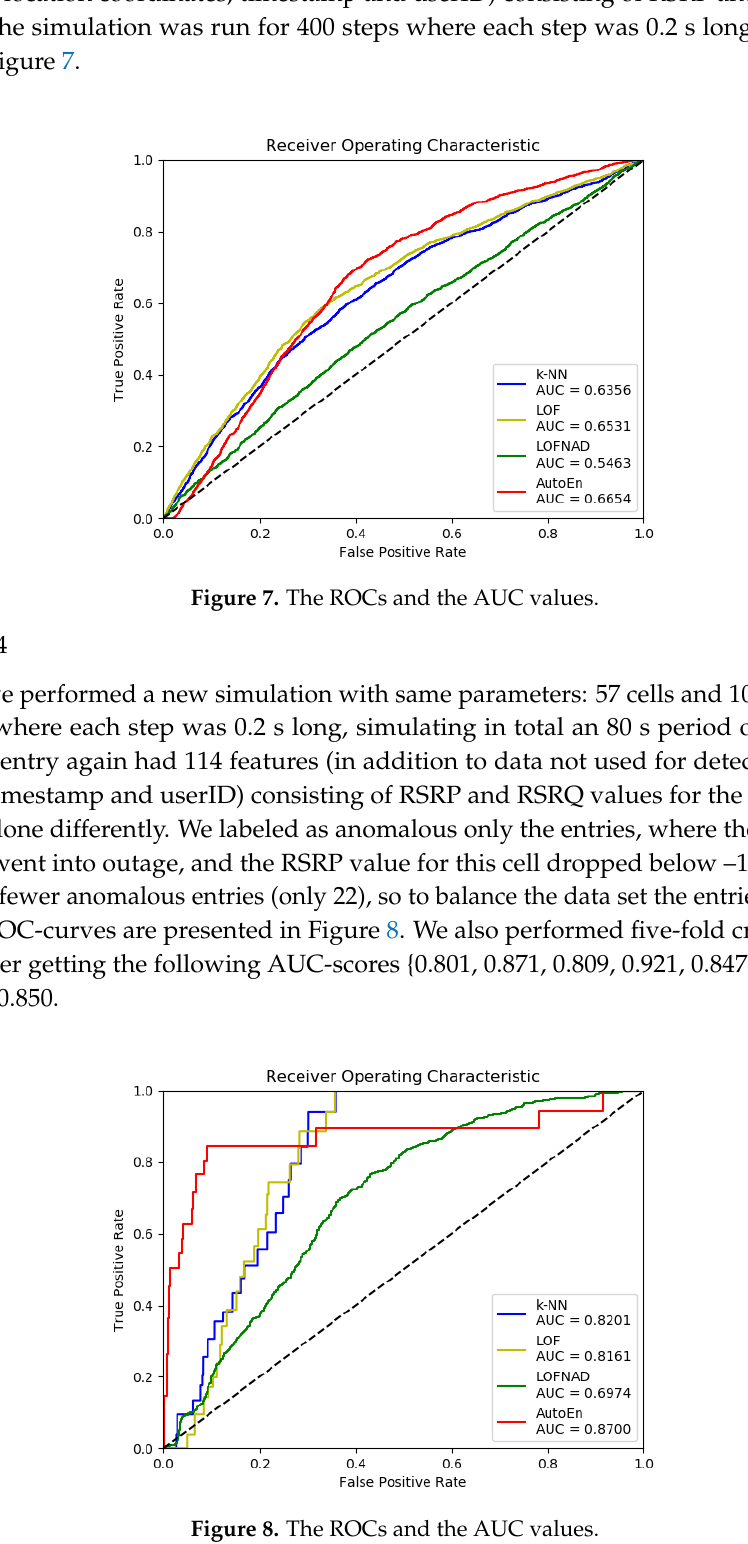
Figure 8. The ROCs and the AUC